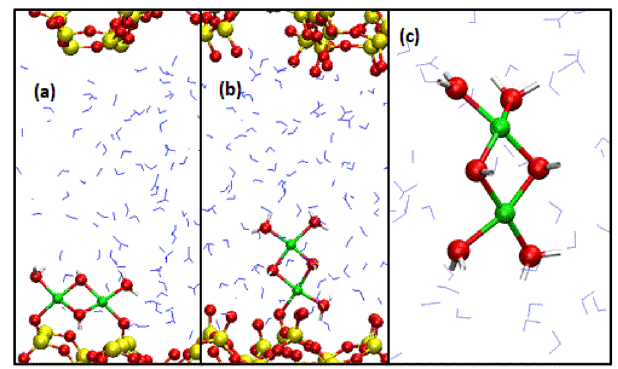
Fig. 1 Types of dimers. a , b Two types of Cu 2 + dimers on silica surfaces. c Cu 2 + dimer in water. Yellow, red, blue, white, and green represent Si, O, O(water), H, and Cu atoms, respectively. Only silica atoms and the H 2 O/ OH − O-atoms directly coordinated to Cu 2 + are depicted as spheres; otherwise, they are lines or